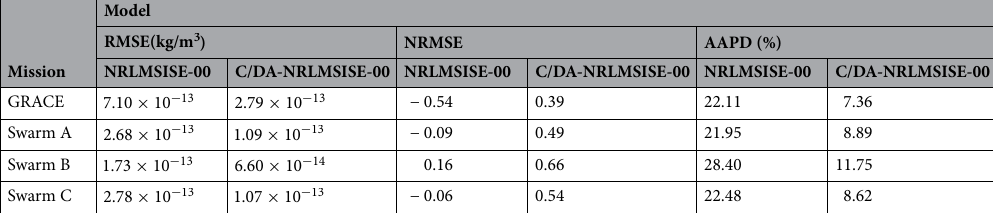
Table 2. A summary of statistical measures between the original and C/DA-NRLMSISE-00 compared to the TNDs derived from GRACE and Swarm measurements during February 2015 in the forecasting mode.